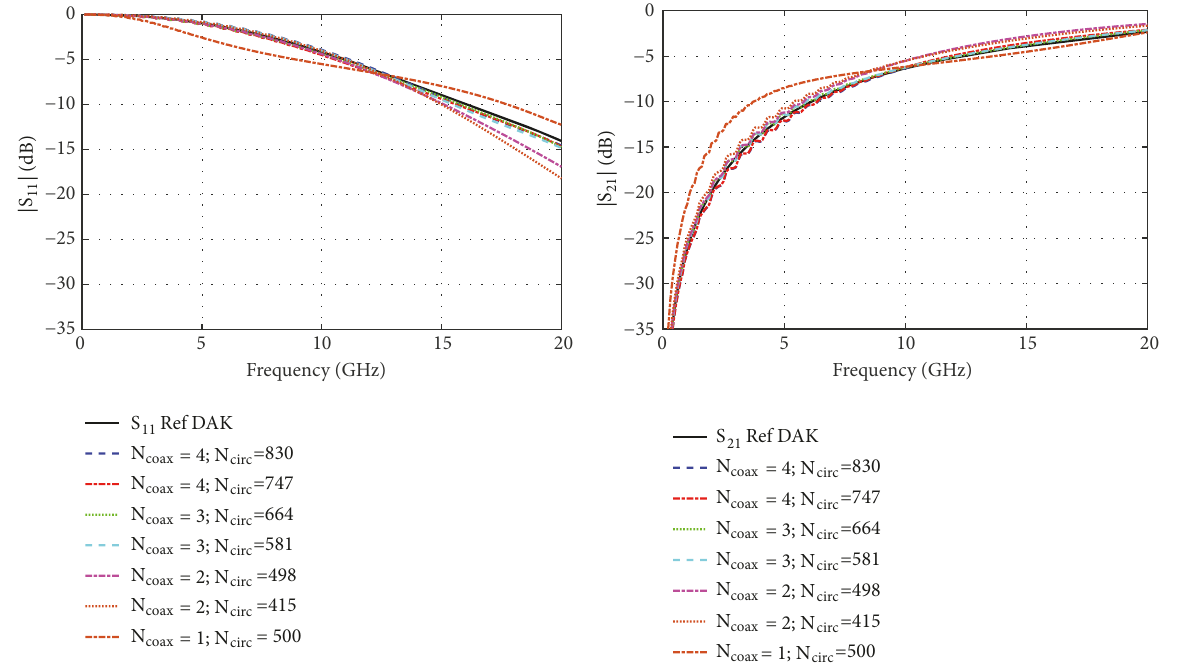
Figure 11: Convergence analysis. Magnitude (dB) of S 11 and S 21 for model A2 with TEM and TM 0 for different values of the number of modes N